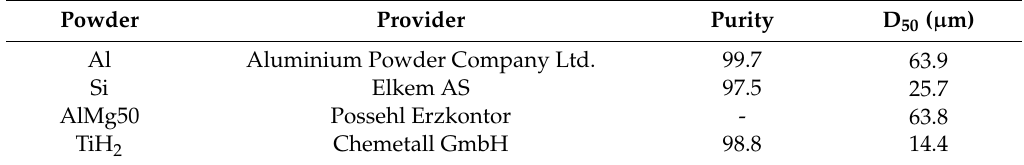
Table 1. List of powders